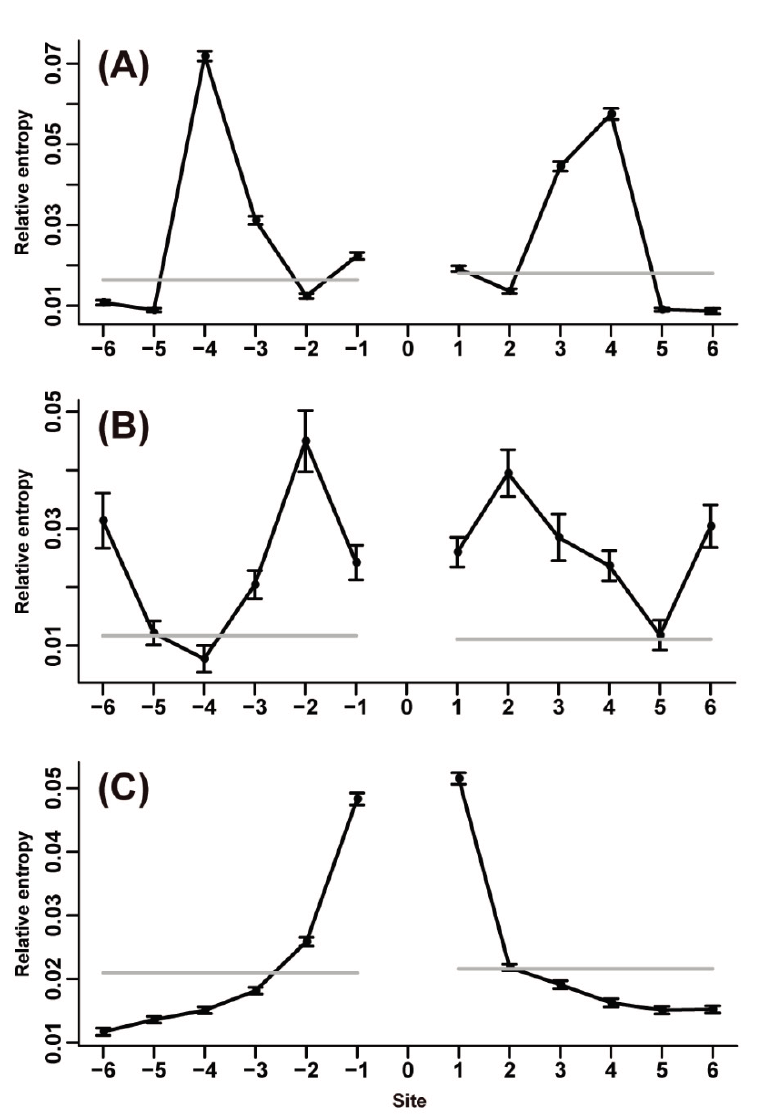
Figure 4. Neighbor preference patterns of V, T, and E in different secondary structures. ( A ) Neighbor preference pattern of the amino acid V in α -helix; ( B ) Neighbor preference pattern of the amino acid T in β -strand; and ( C ) Neighbor preference pattern of the